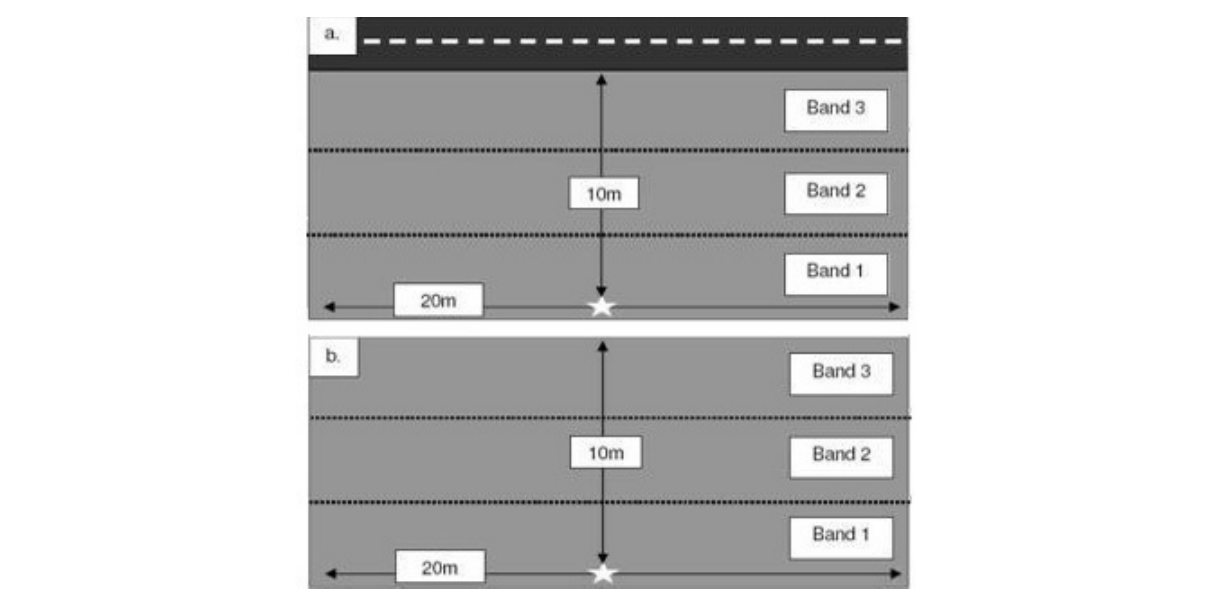
Fig. 1. Monitored band of habitat at field sites (a) with and (b) without roads. The white star represents the origin of the coordinate system and where we began recording frog movements. Dotted black lines correspond to the boundaries of the 3.3 m movement bands used to analyze angular deviation of frog movement